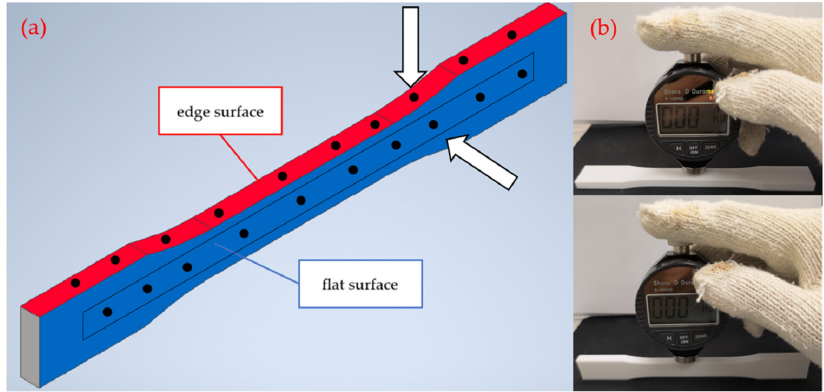
Figure 1. ( a ) The tested point and definition of the tested surface; ( b ) the setup of experiment.